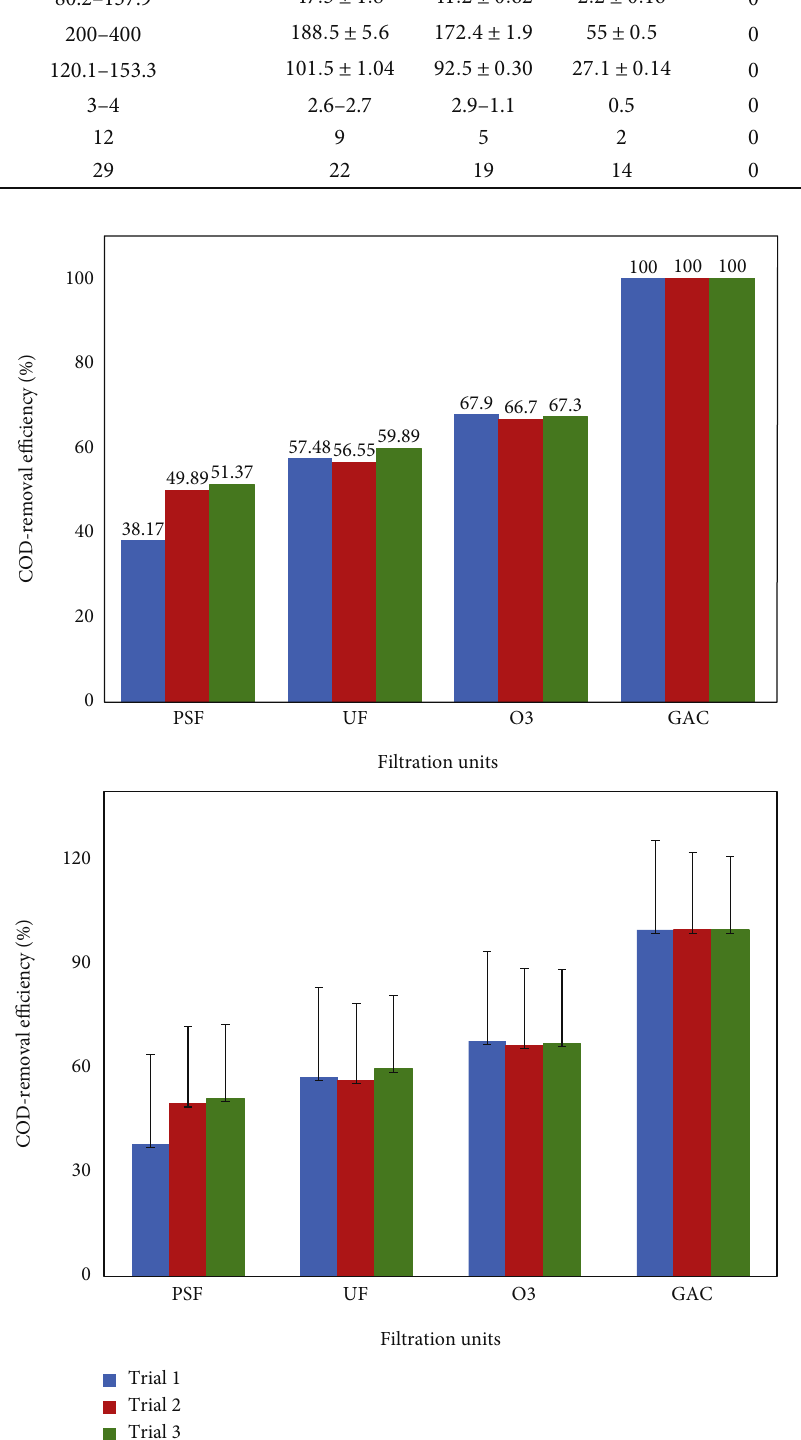
Figure 4: Bar chart representing the removal e ffi ciency of pollutants in PSF, UF, O